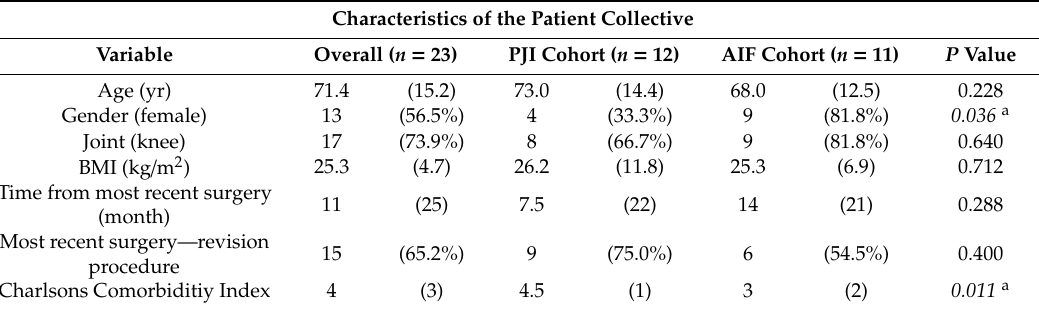
Table 2. Characteristics and demographics of the patient